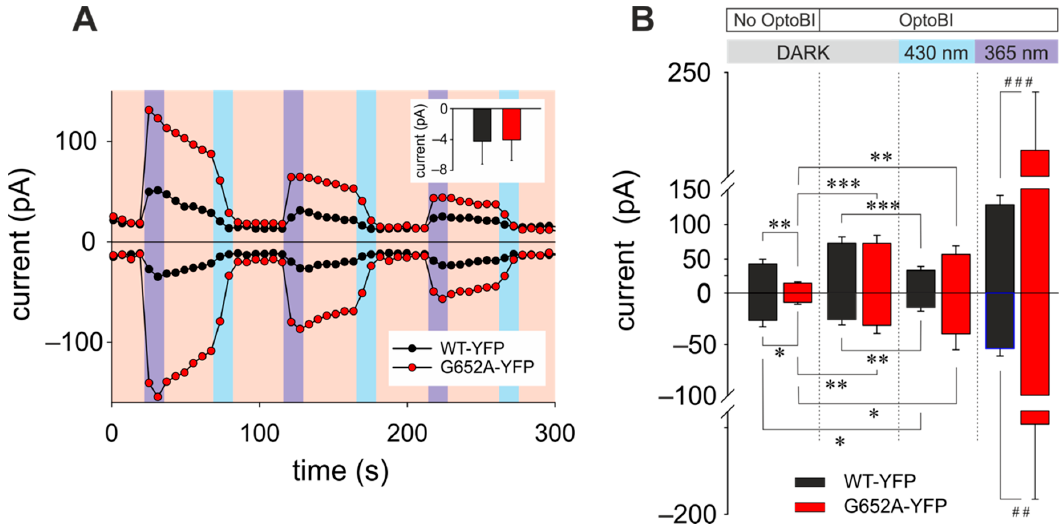
Figure 1. Manipulation of amplitude and temporal features of transient receptor potential canonical 3 (TRPC3) channel signaling patterns by photopharmacology and chemogenetics. ( A ) Representative time courses of the WT-YFP (white) and G652A-YFP (red) conductances recorded at − 90 and 70 mV during repetitive photoconversion of OptoBI-1 (10 μ M). Light illumination cycling is indicated as red (577 nm), UV (365 nm), and blue (430 nm). The insert shows mean ± SEM reversal potentials of currents through WT (black; n = 9) and G652A (red; n = 8) under bionic conditions ([Ca 2+ ] o /[Cs + ] i ). ( B ) Basal (DARK), under blue and UV light application currents responses of WT-YFP and G652A-YFP in absence (No OptoBI) and presence of OptoBI-1 (10 μ M). Currents obtained at − 90 and 70 mV (mean ± SEM). Statistical significance was tested by two tailed t-test (normally distributed values, *) or Mann–Whitney tests (non-normally distributed values, #), * p < 0.05, ** p < 0.01, *** p < 0.001, if not indicated differences are not significant ( p > 0.05).